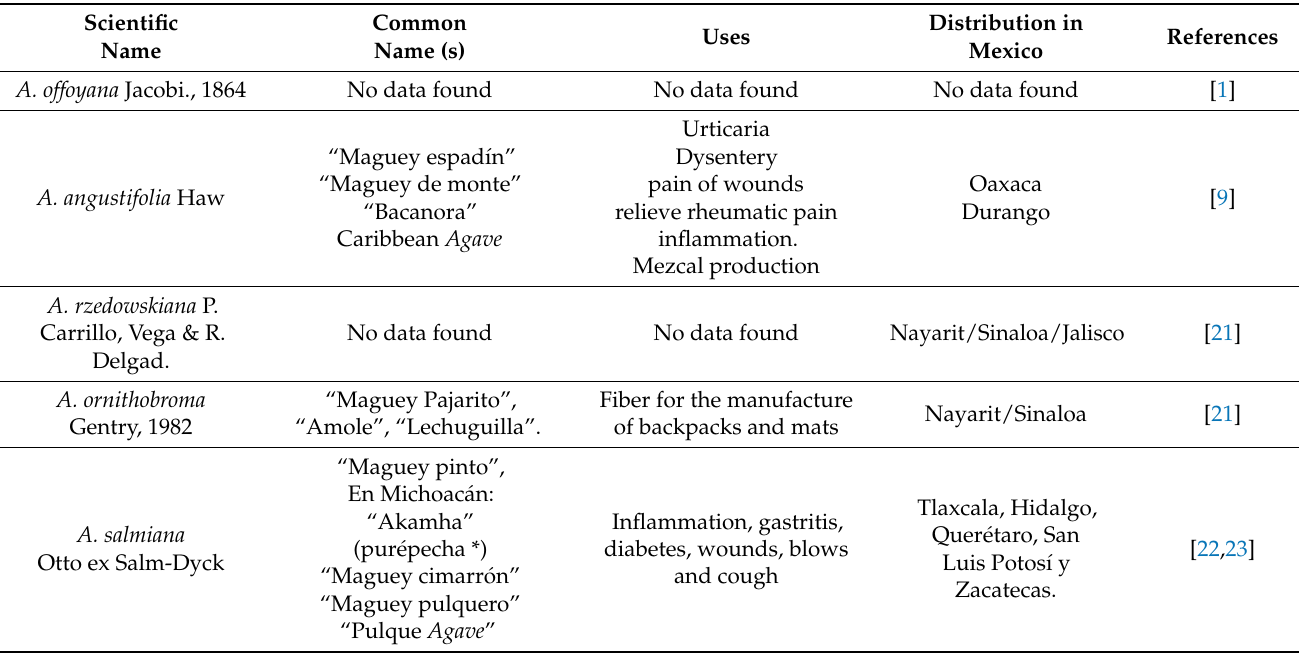
Table 1. Traditional uses, common names and distribution of the Agave species mentioned in the